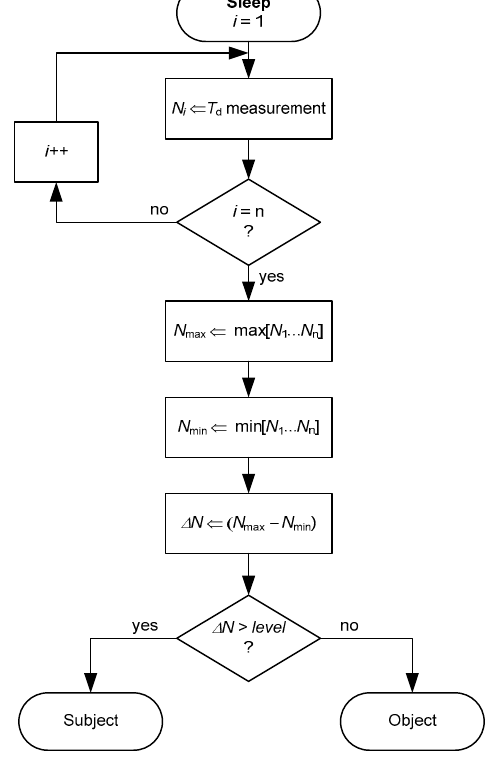
Figure 4. Flowchart of the proposed algorithm for the subject-object classification.